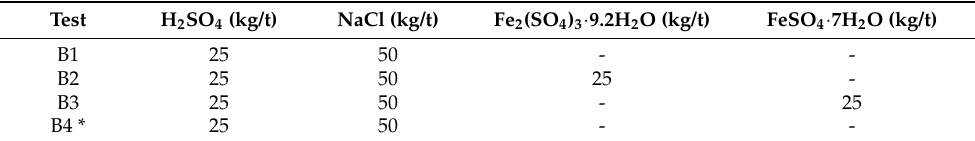
Table 4. Pretreatment tests B.